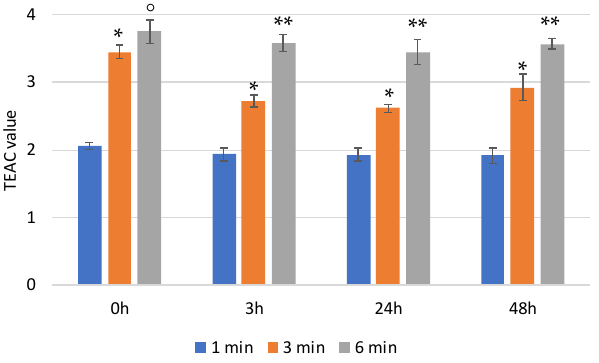
Figure 5. TEAC values of HyCar20 at different incubation times at 37 °C after the addition of hyaluronidase (* p < 0.005 vs. 1 min; ° p < 0.01 vs. 3 min; ** p < 0.005 vs. 3 min).